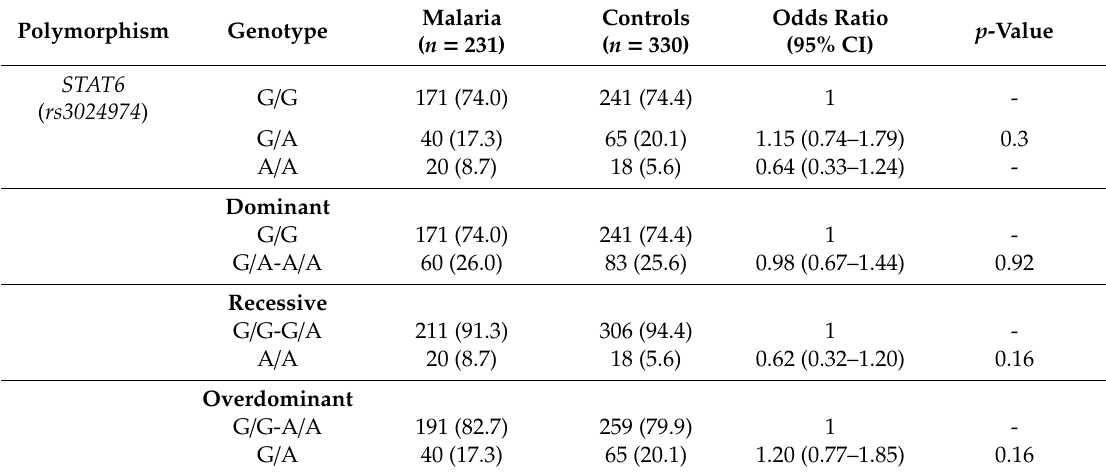
Table 1. Genotypic frequency of the STAT6 gene promoter polymorphism between malaria-infected and control groups.